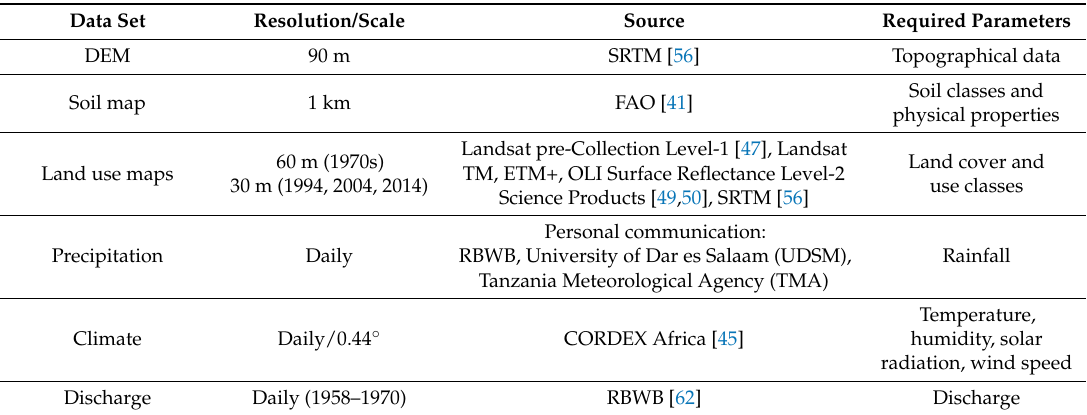
Table 1. Applied datasets, their resolution, sources, and the required parameters in this study.